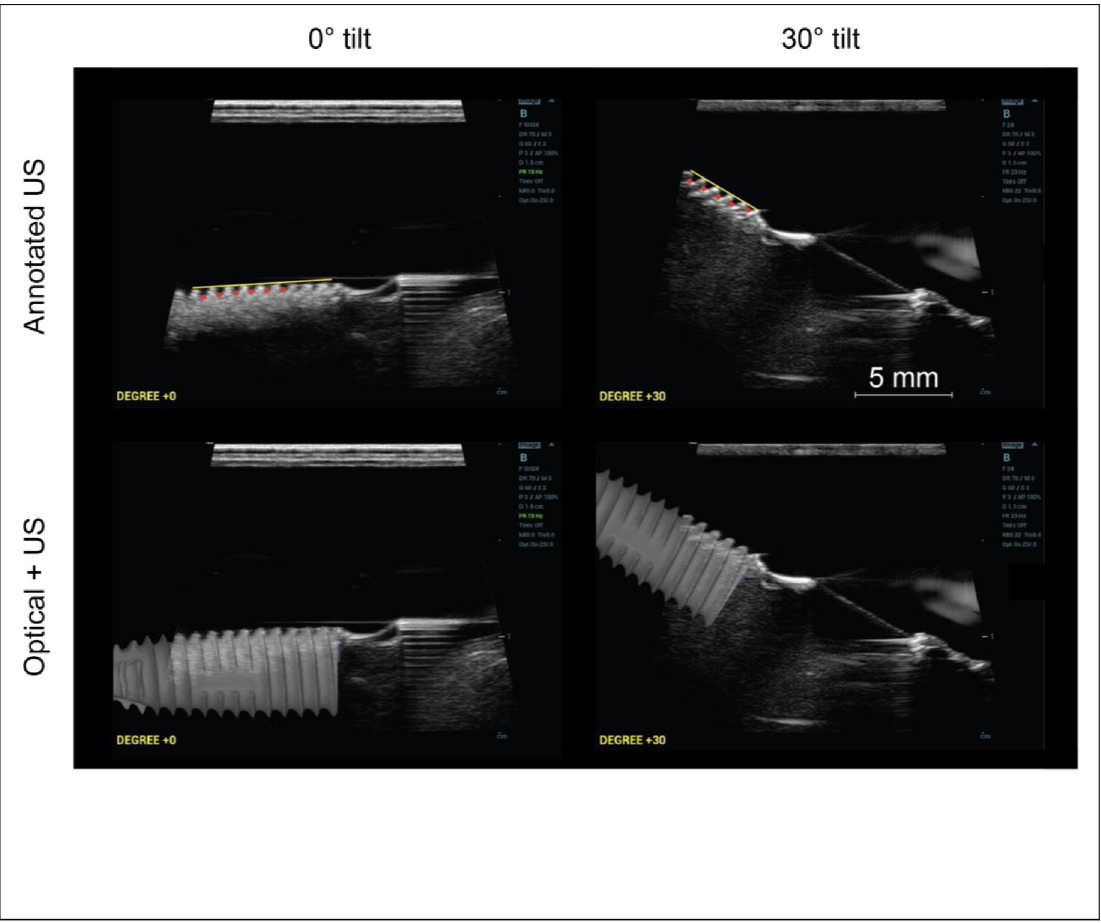
Fig 4. Implant thread pitch and thread depth measurement dependence on the underlying image angle, i.e., angle between the implant and ultrasound array, e.g., DEGREE +0 or +30 in the shown images. Top: A line connecting the peaks of at least 5 consecutive threads is drawn (yellow line). Associated valleys are identified and shown as red dots. The thread depth was measured from the yellow line to each individual red dot and averaged. The thread pitch was measured as the distance between the adjacent red dots that were projected to the yellow line and averaged. Bottom row: Overlaid semi-transparent optical scan of the imaged implant, i.e., a 4.5–13 as shown in S2 Fig. The scale bar is for all images.